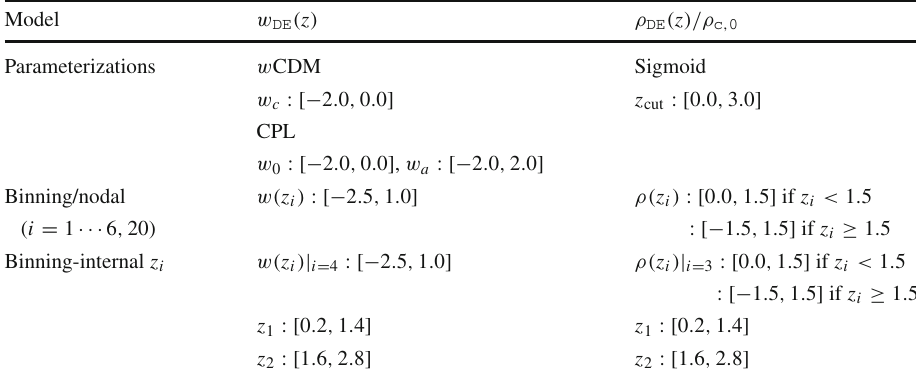
Table 2 Additional parameters and their flat prior range